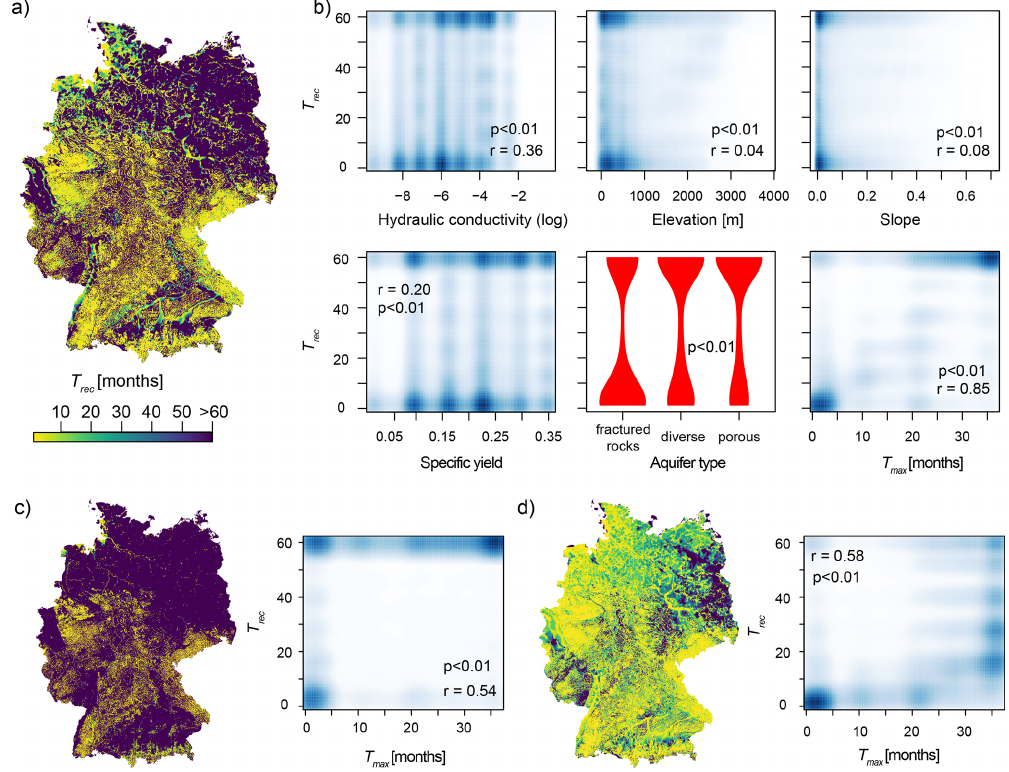
Figure 9. Recovery time T rec for S RECOV . (a) Spatial distribution of T rec across Germany, (b) relationship between T rec and model param- eters hydraulic conductivity, elevation, slope and specific yield, aquifer type (taken from HÜK200) and precipitation accumulation time that has the maximum correlation with groundwater T max (taken from Hellwig et al., 2020). Panels (c) and (d) show the spatial distribution of T rec and T rec over T max for dry and wet conditions, respectively, during drought recovery. Blue colours indicate the smoothed density derived from all model grid cells. Red violins illustrate the distribution of T rec in three different categories of aquifer type. r is the Pearson correlation coefficient for the variables compared, and p is the corresponding p